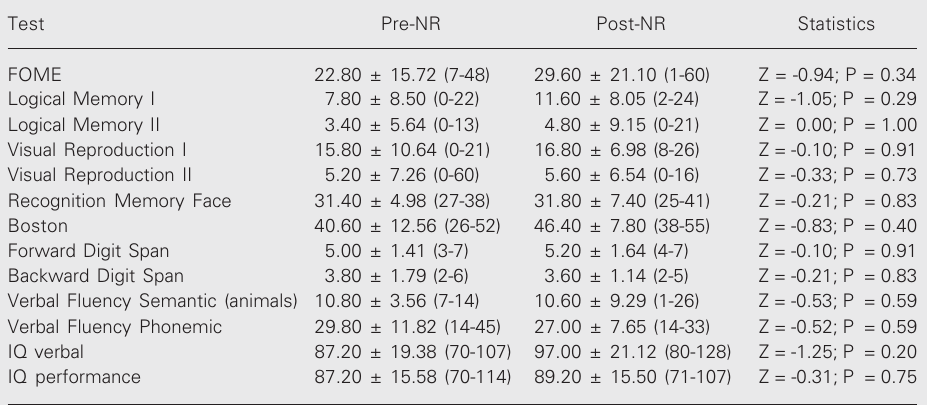
Table 3. Results of the neuropsychological tests applied to patients pre- and post-neuropsychlogical rehabili- tation (NR).